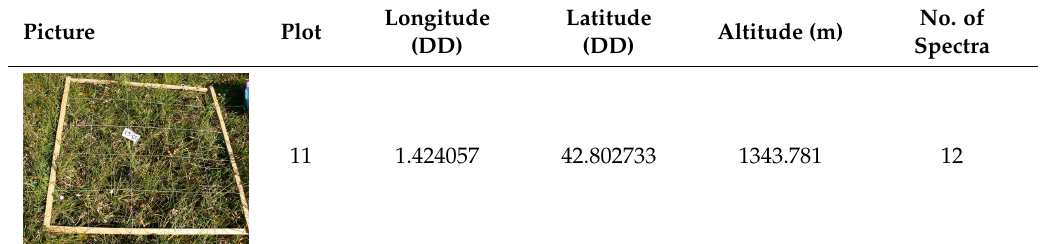
Table A6. Pictures, plots, geographic coordinates and number of spectra of Menyanthes trifoliata (METR). Picture